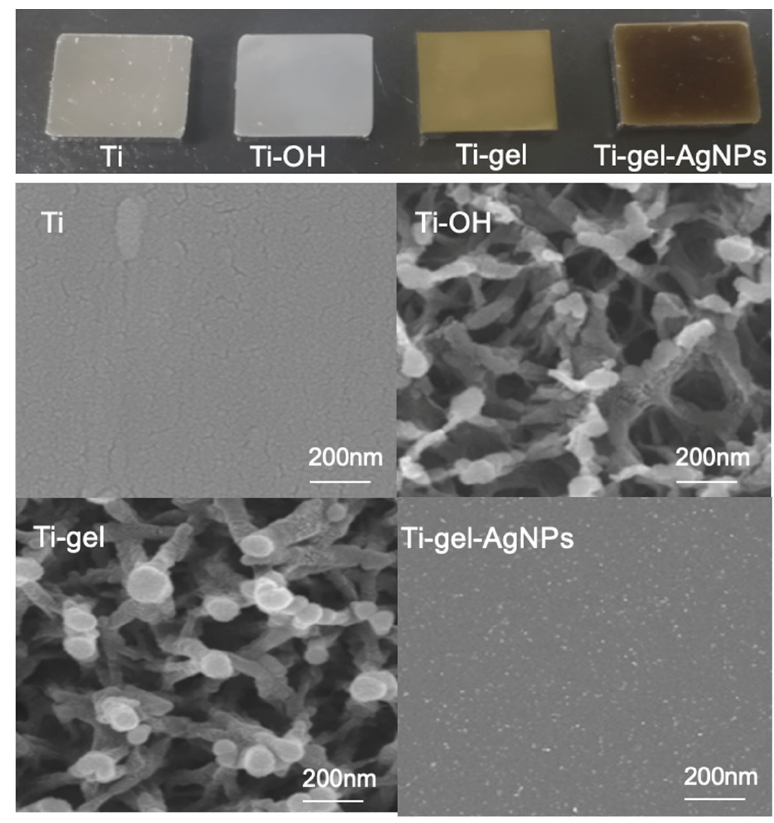
Figure 2. Surface morphology of titanium alloy plates with different treatments.